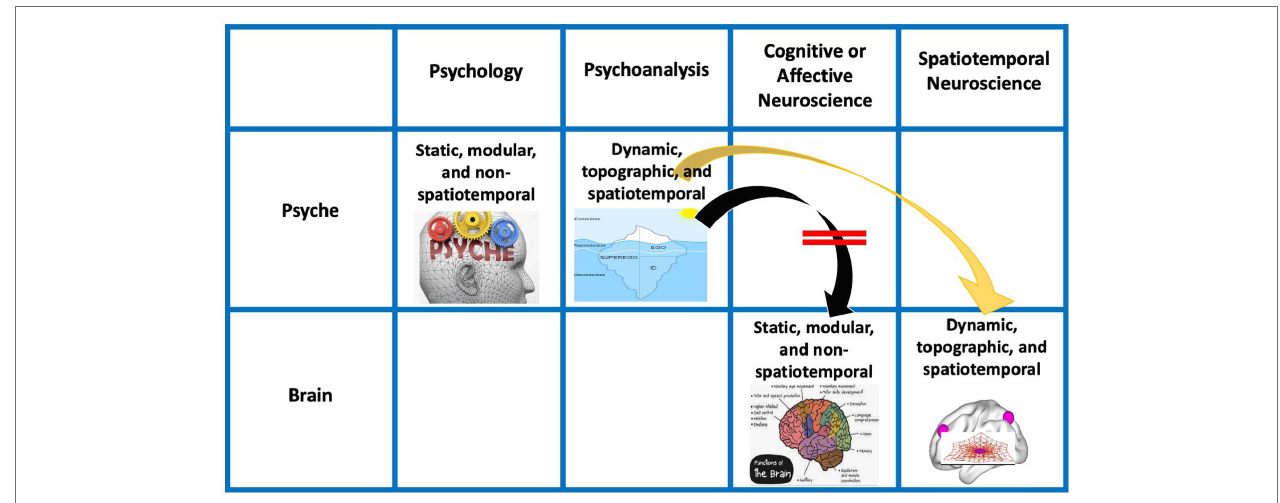
FIGURE 2 | Views of psyche and brain in psychology, psychoanalysis, and different forms of neuroscience. Arrows indicate the combination of the models of the psyche in Psychology and Psychoanalysis with the model of brain as in Cognitive/Affective Neuroscience (green arrow, black arrow) as well as of psychoanalysis with Spatiotemporal Neuroscience (orrange arrow). Red lines (on the black arrow) indicate the mismatch between the models of psyche (in psychoanalysis) and brain (in Coginitive/Affective